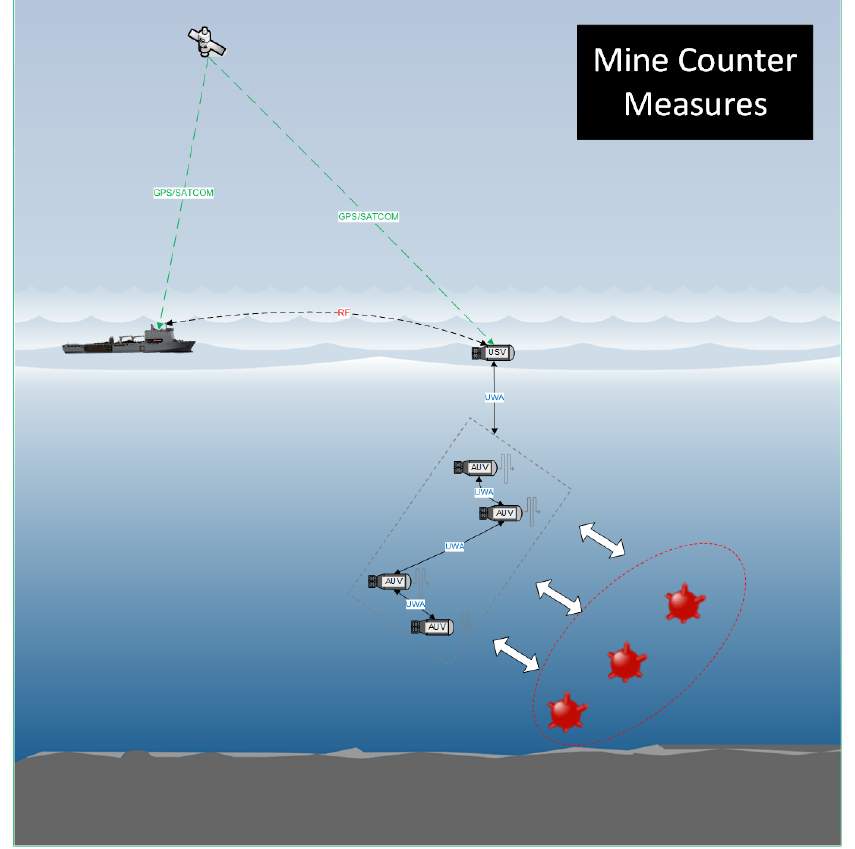
Figure 1. Mine Counter Measure use case. The Autonomous Underwater Vehicles (AUVs) communicate over acoustic channels, reporting collected data back to the command station through an Unmanned Surface Vehicle (USV). This surface vehicle is localised via